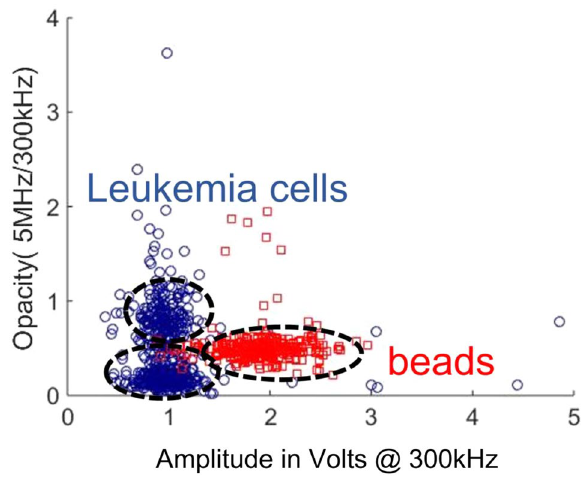
Figure 13. Opacity scatter plot of beads and leukemia cells at a low frequency of 300 kHz and a high frequency of 5